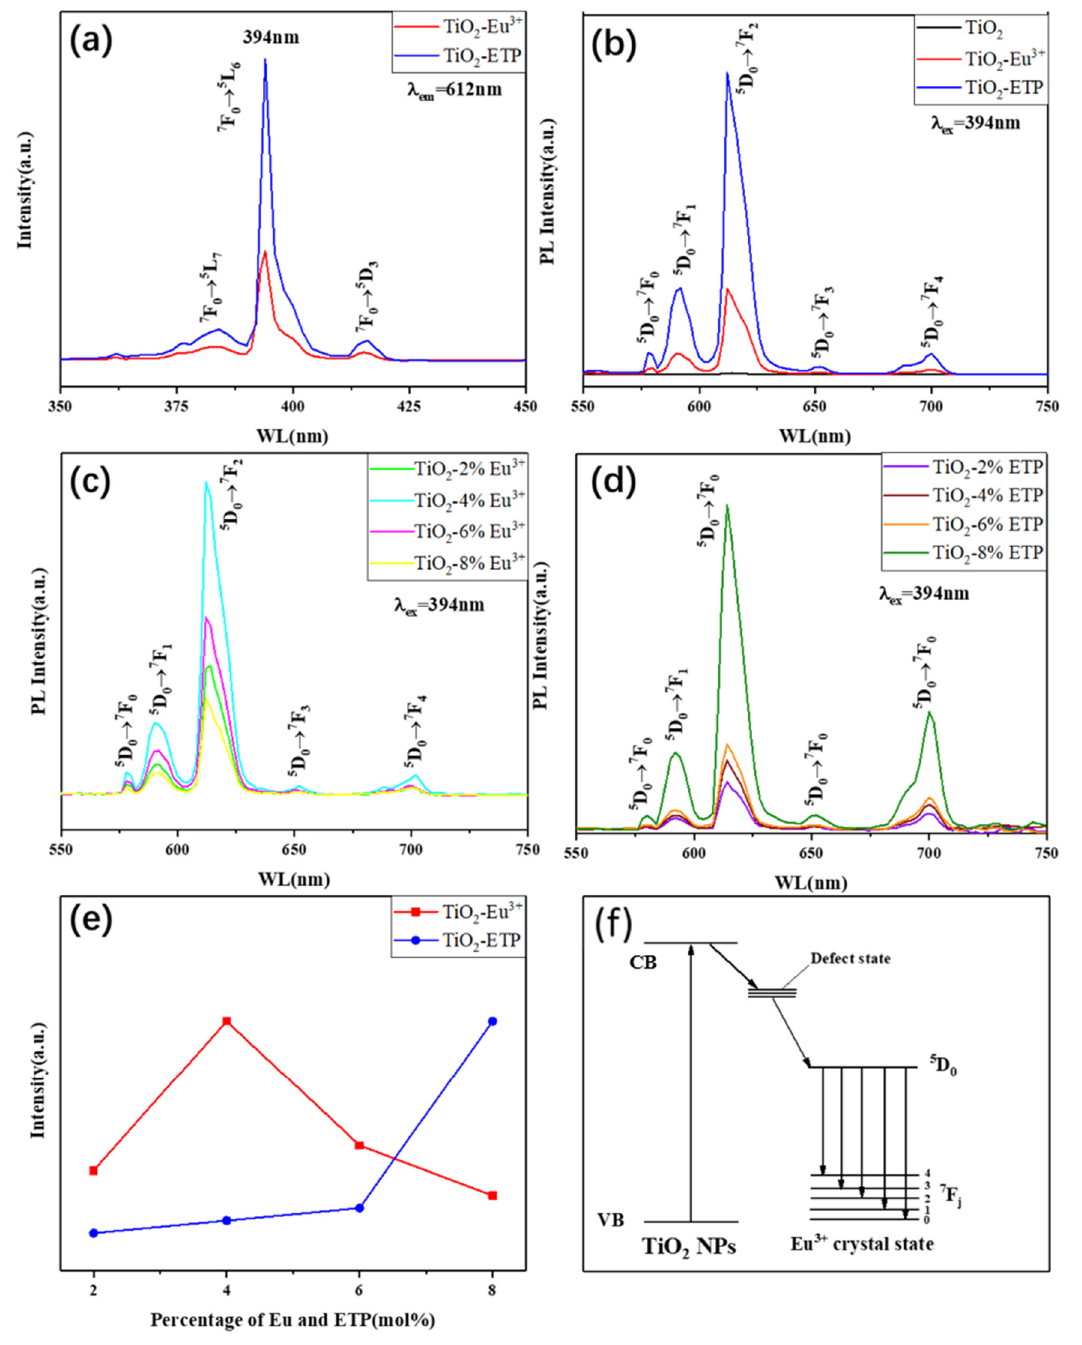
Figure 8. The photoluminescence excitation spectra ( a ) and emission spectra ( b – d ) of TiO 2 , TiO 2 ‐ Eu 3+ and TiO 2 ‐ ETP nanoparticles; fluorescence intensity vs. concentration curve ( e ) and energy transfer diagram ( f ) of TiO 2 , TiO 2 ‐ Eu 3+ and TiO 2 ‐ ETP.